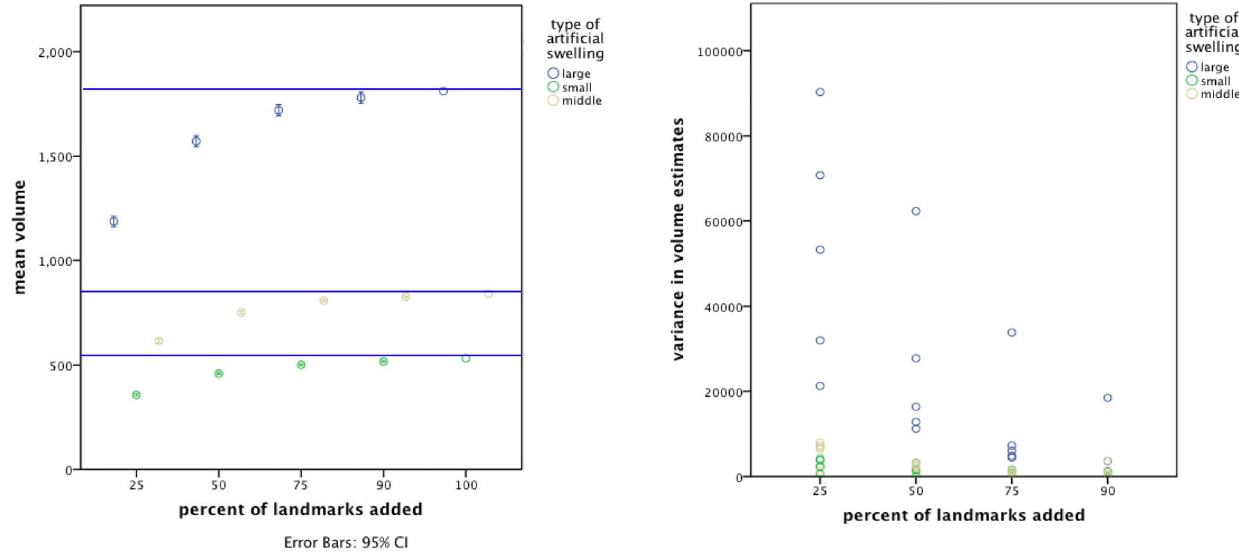
Figure 7. Means and variances of the bootstrapped volumes per model type and landmarks added. a) The mean volume was affected by the type of model (large, middle, or small) as well as by the percentage of landmarks added. With an increasing number of landmarks the mean volume asymptotically increased. The blue lines indicate the values of the mean volumes of the five replications with 100% of the landmarks for each artificial swelling size. b) Variances in volume results were influenced by the type of model and the number of landmarks. As the percentage of landmarks added increased, the variance in volume results decreased.